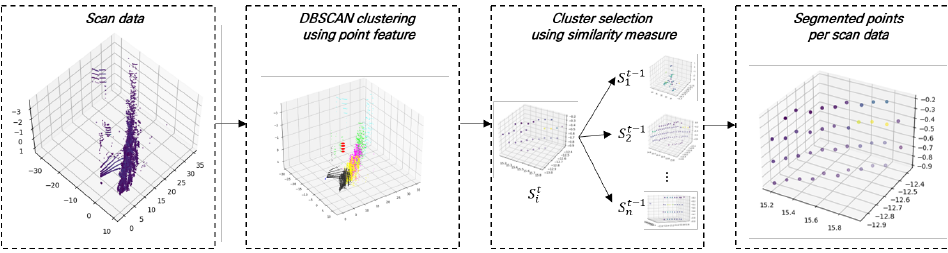
Figure 5. Overall procedure of feature extraction